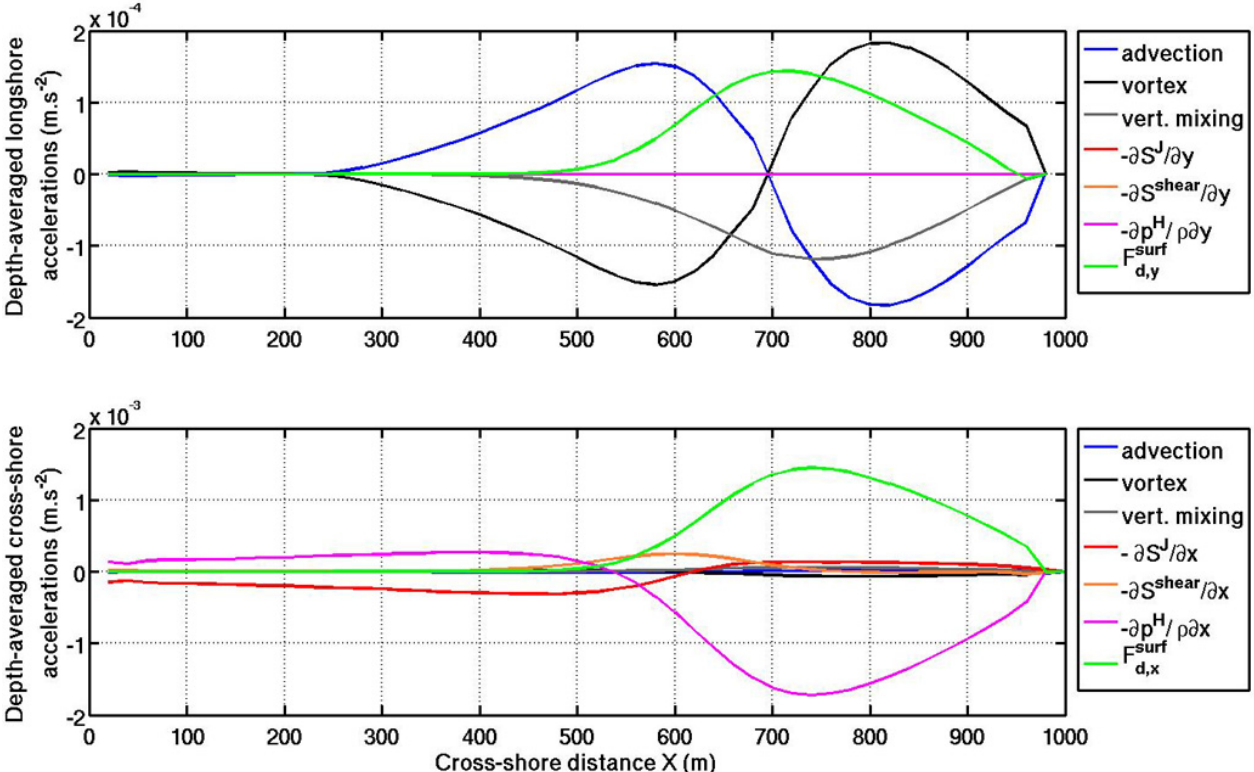
Fig. 3. Depth-averaged values of the different terms in the alongshore (top) and cross-shore (bottom) momentum balance, versus cross-shore distance: the advection, the vortex force, the vertical mixing (vert. mixing), the pressure gradient ( − 1 Bernoulli’s head gradient ( − ∂S